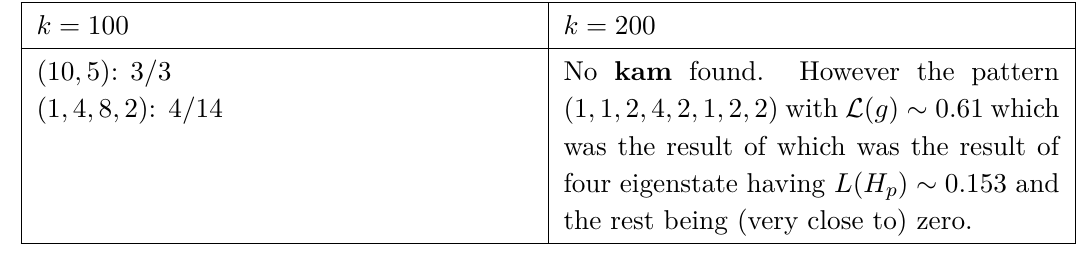
Table 1 . Kam ness for L 24 on su (4) .